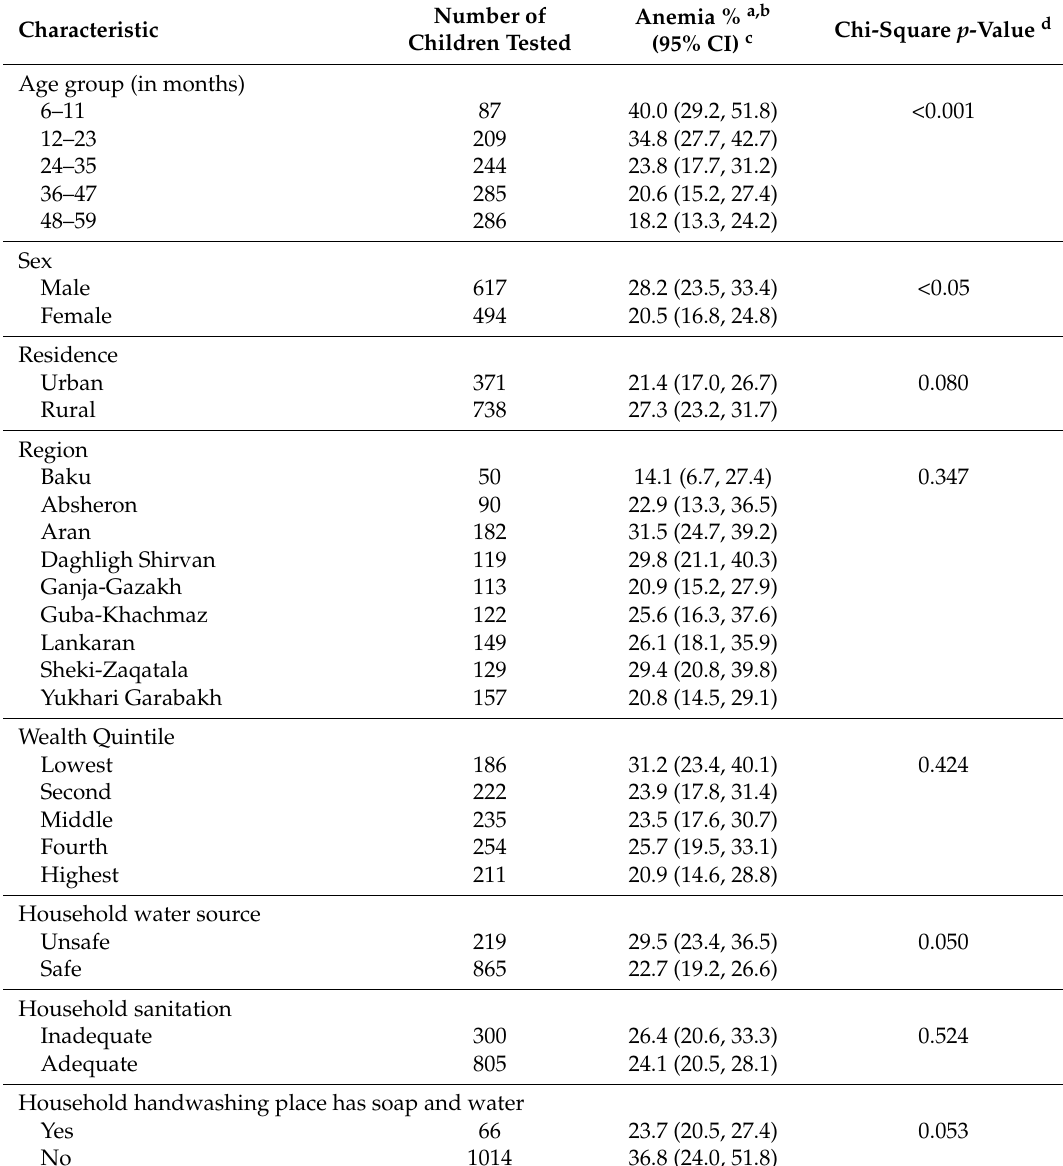
Table 3. Anemia prevalence in children 6–59 months by demographic characteristics and nutritional, disease, and environmental risk factors of anemia, Azerbaijan